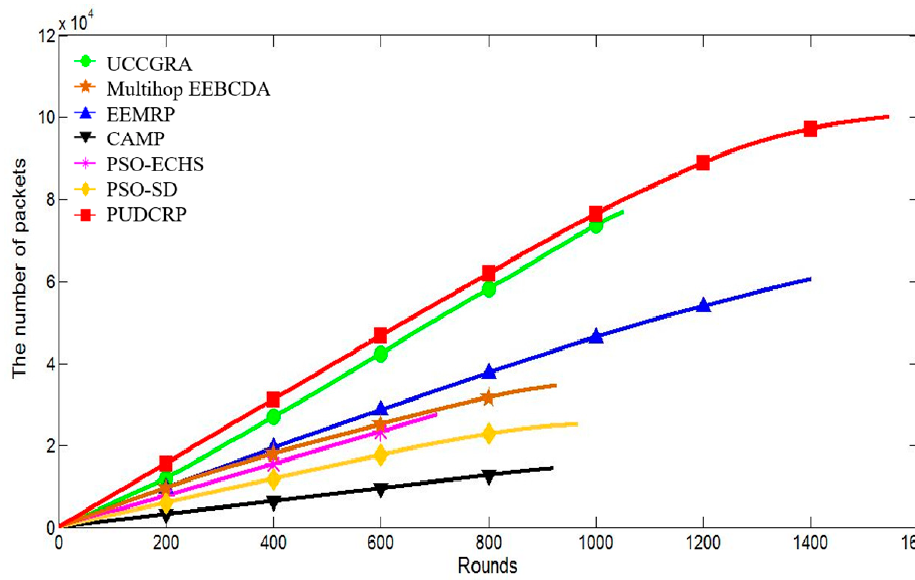
Figure 18. The number of packets received by the BS in the 400 m × 400 m network area.